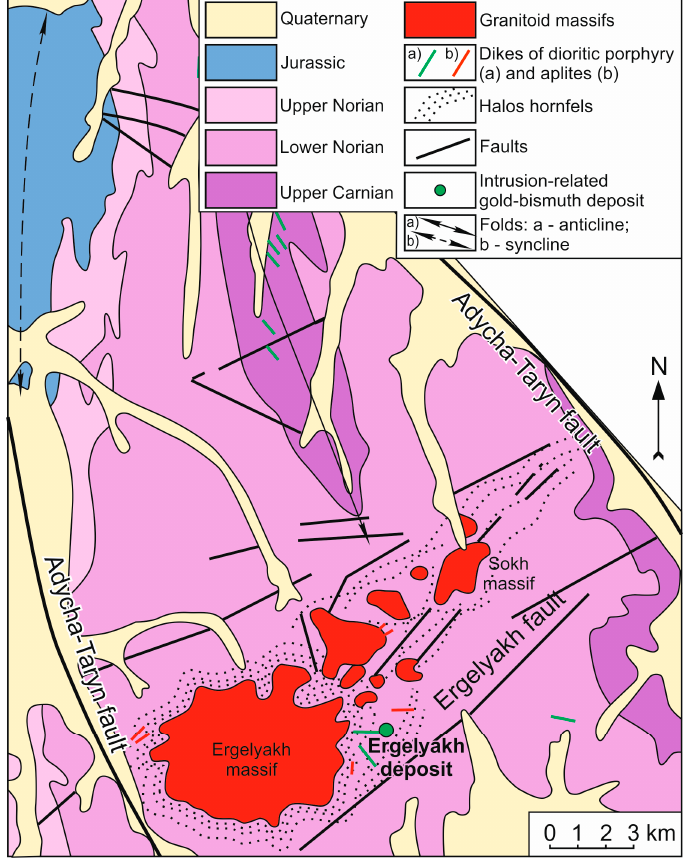
Figure 2. Geologic map of the area of the Ergelyakh and Sokh massifs, including the Ergelyakh intrusion ‐ related gold–bismuth deposit.